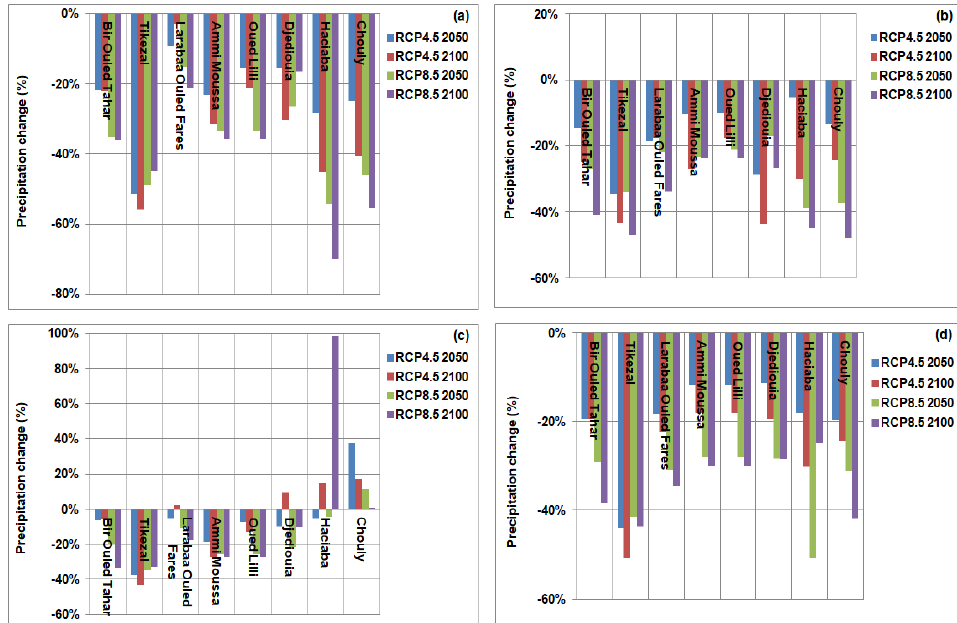
Figure 5. Changes in winter precipitation relative to the historical period under two scenarios (RCP4.5 and RCP8.5): ( a ) quantile mapping, ( b ) scaled distribution mapping, ( c ) quantile delta mapping, and ( d ) model (RAW).